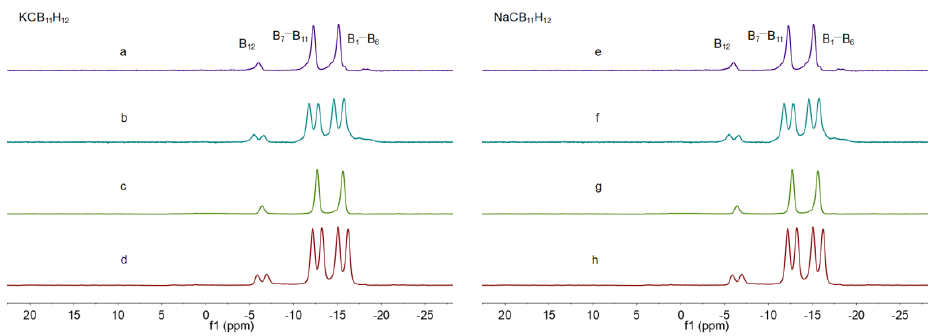
Figure 1. 11 B{ 1 H} and 11 B NMR spectra: ( a ) crude reaction mixture of K[CB 11 H 12 ] after 3 days of heating at 60 ◦ C ( 11 B{ 1 H} NMR); ( b ) crude reaction mixture of K[CB 11 H 12 ] after 3 days of heating at 60 ◦ C ( 11 B NMR); ( c ) purified K[CB 11 H 12 ] in DMSO- d 6 ( 11 B{ 1 H} NMR); ( d ) purified K[CB 11 H 12 ] in DMSO- d 6 ( 11 B NMR); ( e ) crude reaction mixture of Na[CB 11 H 12 ] after 3 days of heating at 60 ◦ C ( 11 B{ 1 H} NMR); ( f ) crude reaction mixture of Na[CB 11 H 12 ] after 3 days of heating at 60 ◦ C ( 11 B NMR); ( g ) purified Na[CB 11 H 12 ] in DMSO- d 6 ( 11 B{ 1 H} NMR); ( h ) purified Na[CB 11 H 12 ] in DMSO- d 6 ( 11 B NMR).